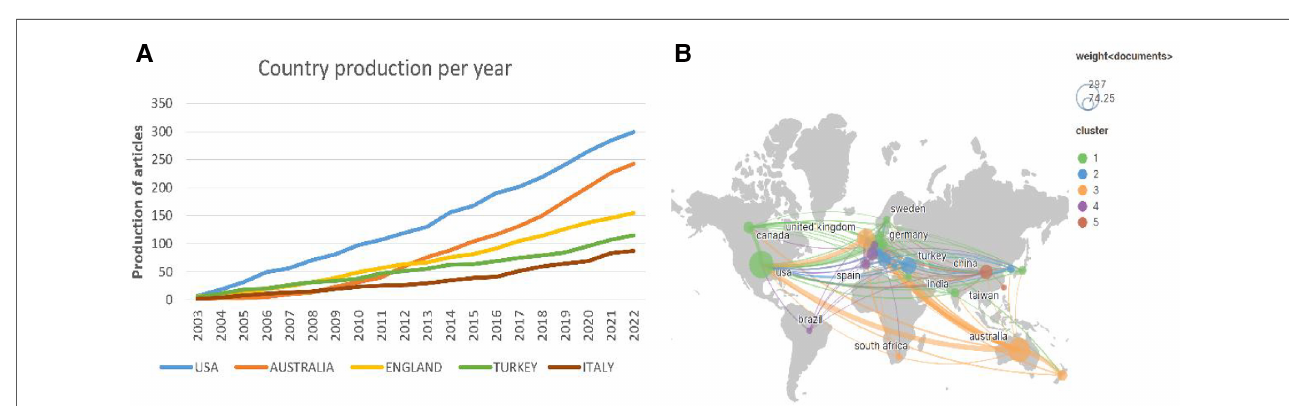
FIGURE 3 Analysis of countries/regions related to pediatric bronchiectasis between 2003 and 2022. ( A ) Trend chart of the number of publications in the top fi ve countries. ( B ) Cooperation network map of countries. Node size represents the number of publications. The lines represent cooperation relationships, and the thickness of the line represents the connection